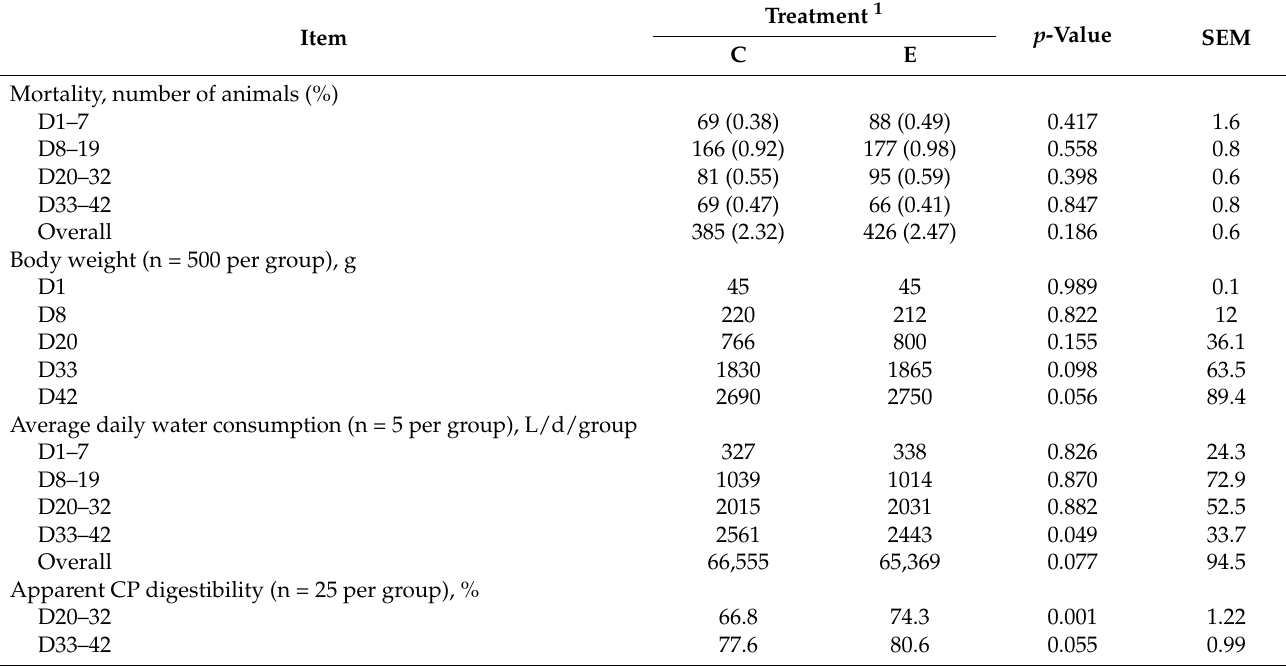
Table 2. Mortality and body weight of broiler chicken, water consumption per group, and apparent crude protein